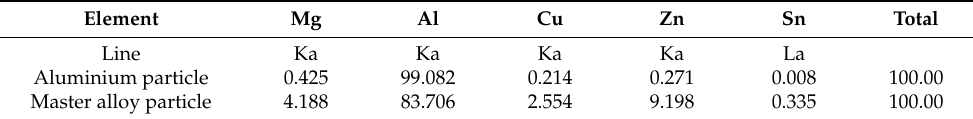
Table 2. Energy dispersive analysis of Al and master alloy particles/mass%.